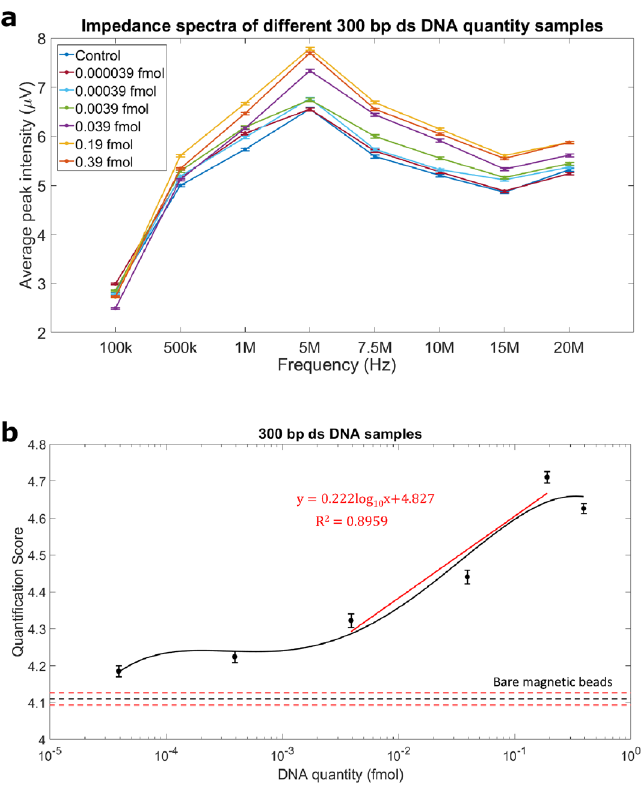
Figure 2. Effect of DNA concentration attached to the bead on impedance response. ( a ) Impedance spectra for beads attached with different concentrations of 300 bp ds DNA (Table 1) and negative control beads (paramagnetic M280, Invitrogen). For all samples measured, impedance peak response increased as frequency increased from 100 kHz to 5 MHz and decreased as frequency increased to 15 MHz. ( b ) The quantification score of different 300 bp DNA beads and negative control was calculated based on impedance responses measured at 8 frequencies. The black solid line shows the polynomial fitted curve across the 6? different DNA concentrations. The red line shows the linear correlations between DNA quantity and quantification score in the linear region. Error bars represent standard error of mean. Horizontal black and red dotted lines represent the average quantification score of the negative control samples and negative control ± standard error,